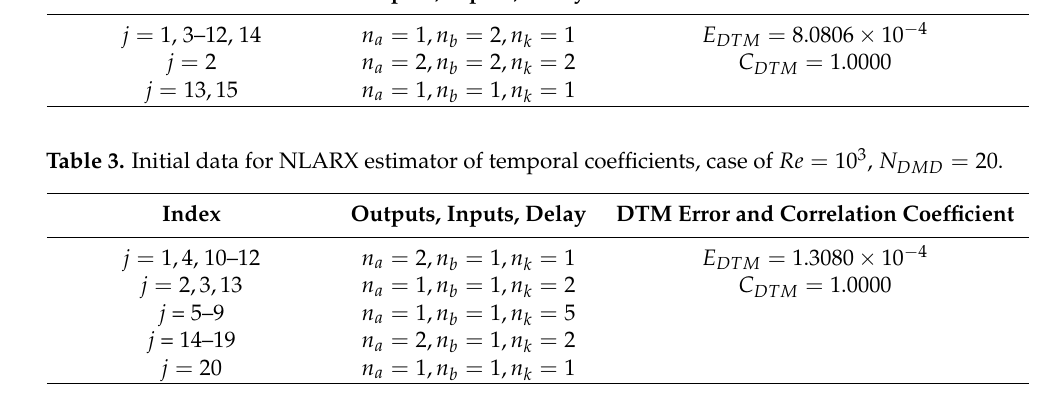
Table 4. Initial data for NLARX estimator of temporal coefficients, case of Re = 10 4 , N DMD =